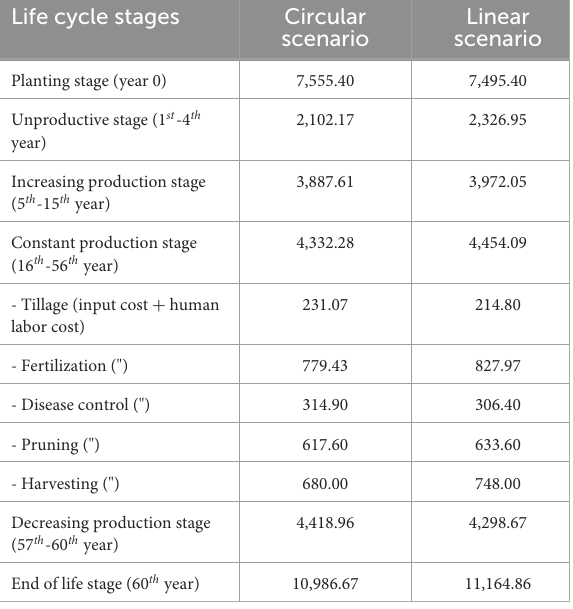
TABLE 5 Olive oil extraction costs of the circular vs. linear scenario ( e kg − 1 ). Item cost Circular